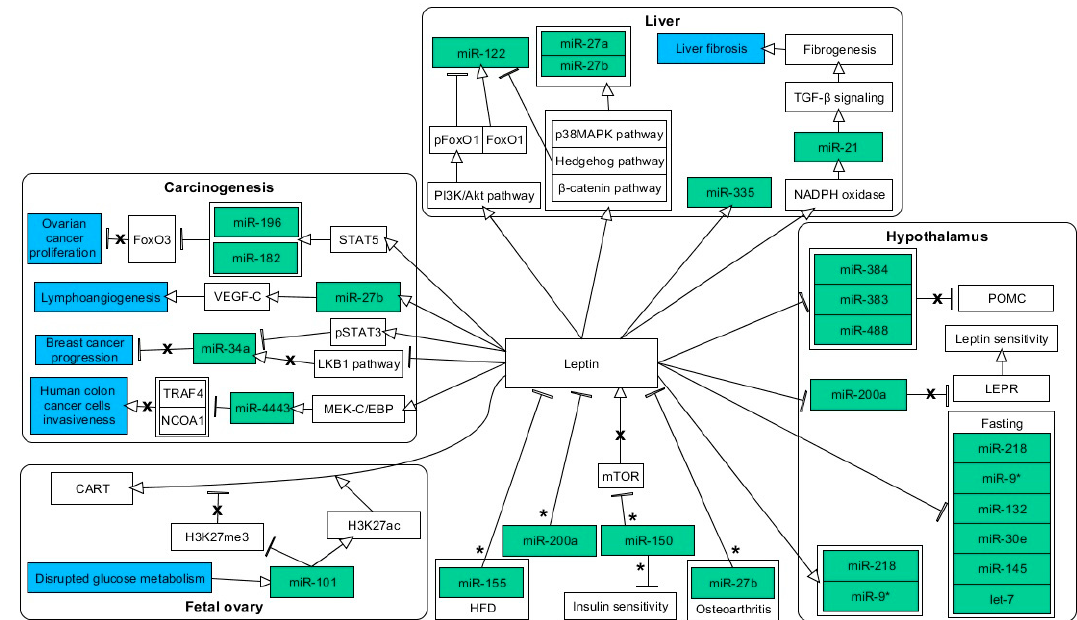
Figure 1. Proposed model of miRNA participation in downstream signaling and regulation of leptin expression. miRNAs and negative outcomes are highlighted in green and blue, respectively. Associations are indicated by arrows (stimulation) and T-bars (inhibition). Actions related to boxes refer to all items inside the box. Arrows and T-bars which are crossed out mark the abrogation of the respective type of regulation. Associations were based on the leptin administration or the ob/ob model excluding those marked by asterisks (exclusively, the effect of miRNAs on leptin expression was measured, without prior manipulation of the leptin level). The figure was made using the PathVisio 3.3.0 free open-source software [53].